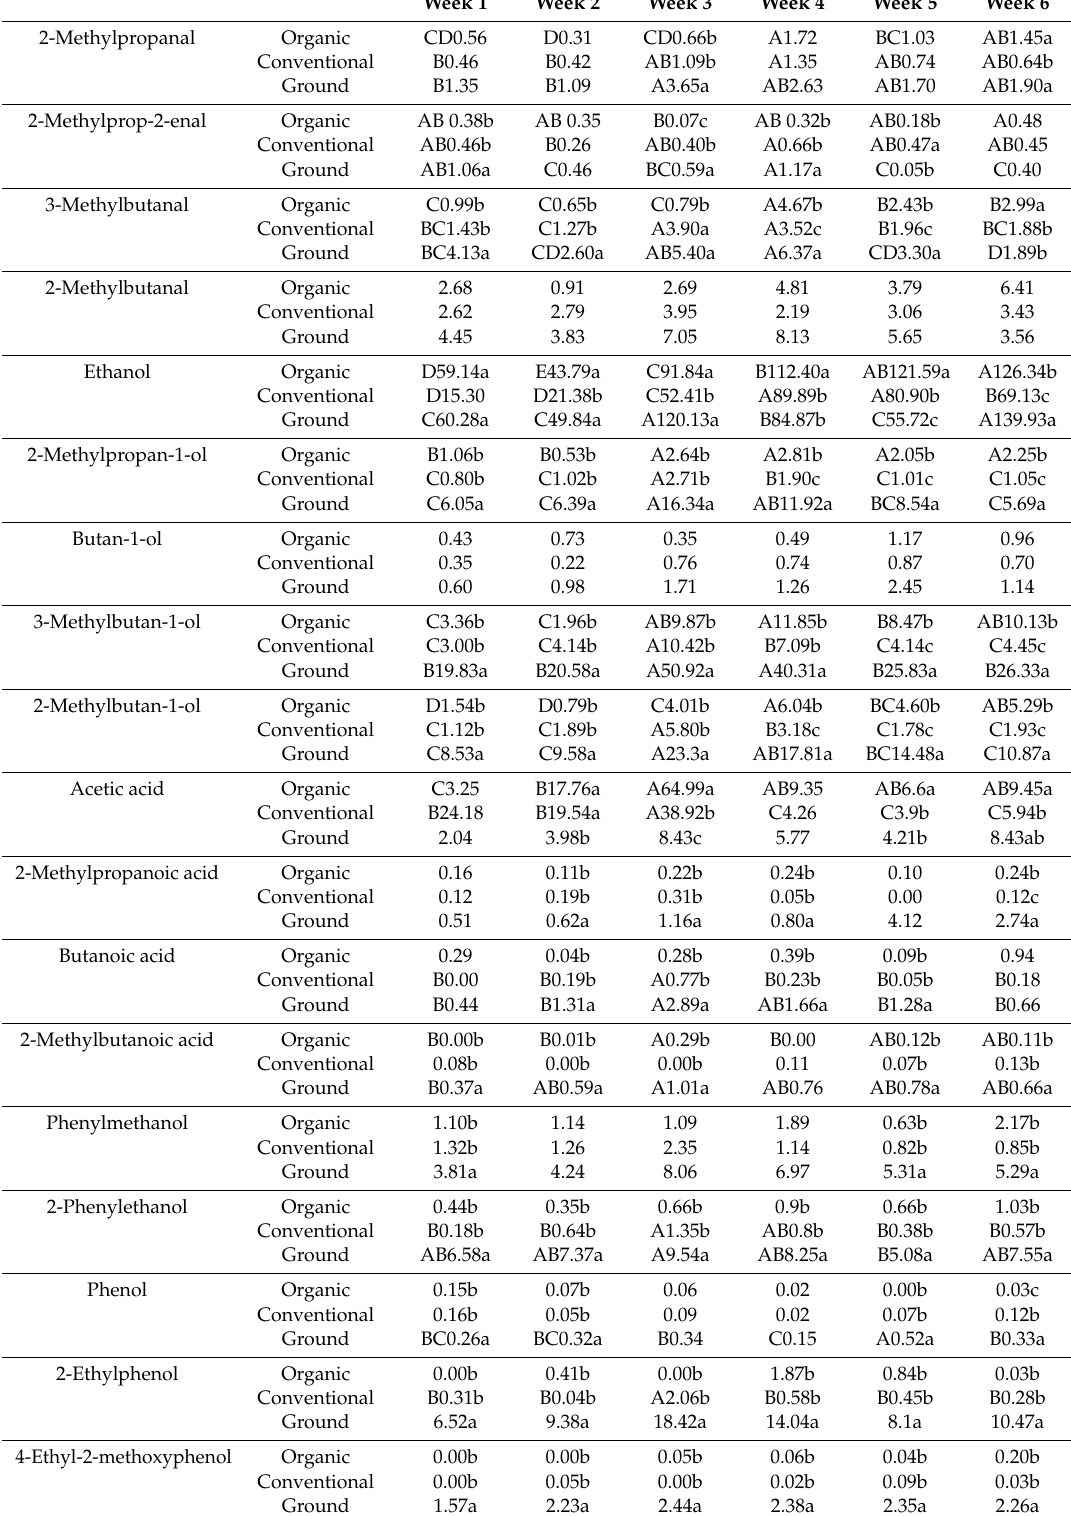
Table 4. Results (means and significance *) for the most representative fermentation compounds of the Verdial de Badajoz oil headspace significantly a ff ected by the organic production, harvesting method and / or harvesting time according to Table